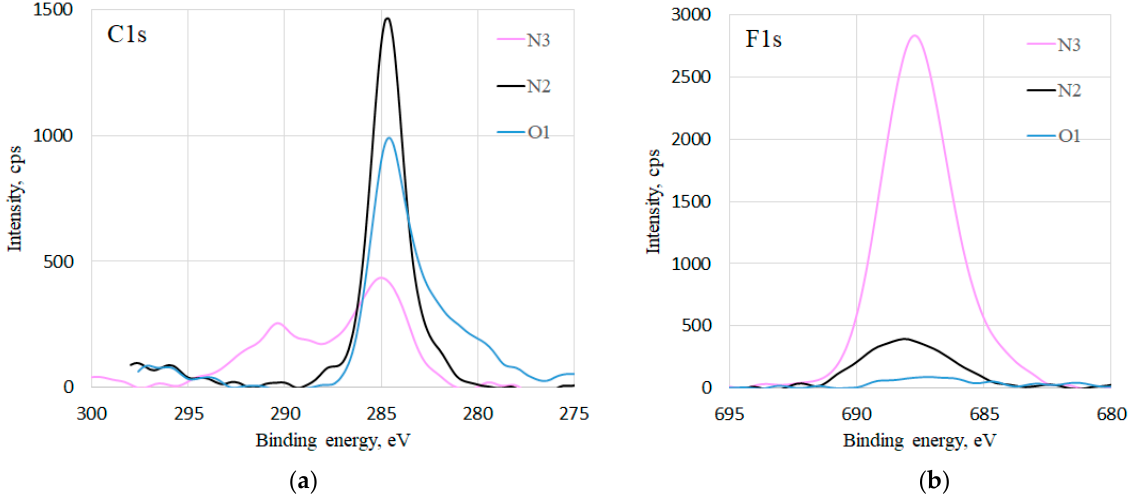
Figure 7. XPS high resolution spectra of ( a ) C1s and ( b ) F1s for samples N2, O1 after all condensation experiments, and a referent new-coated sample N3 not subjected to condensation experiments.